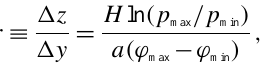
Fig. 6. Trajectory vertical to horizontal aspect ratio r (km per 1000km, top) and integrated mass flux along trajectories (in 10 5 kg/m/s, bottom) for CMAM. Left: annual means as a function of arrival pressure and latitude (color shading, note logarithmic scale). Stratospheric entry latitudes (contours, in degrees, southern latitudes dashed, zero contour omitted) and the contour r =1 · 10 − 3 (white) are overplotted in the top. Annual mean trajectory aspect ratio r (contours, in km per 1000 km, note irregular contour spacing) are overplotted in the bottom. Right: as a function of arrival latitude with arrival pressure set to correspond to Θ TP +30 K (roughly the top of the ExTL). Note stretched abscissa, which is proportional to cos ϕ to highlight extratropical areas (tropical values, equatorward of 30 ◦ , are omitted). Green: boreal spring, brown: boreal autumn, black: annual mean.